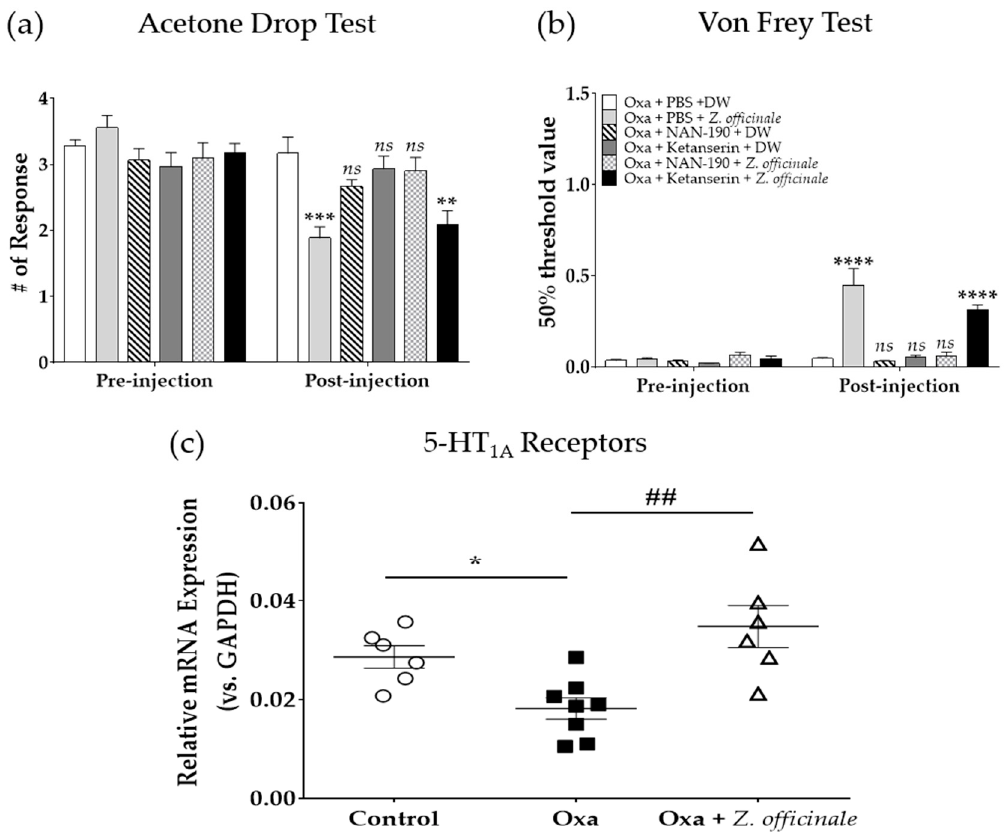
Figure 4. Effect of intrathecal injection of NAN-190 or ketanserin on Z. officinale -dependent inhibition of oxaliplatin-induced neuropathic pain in mice ( a,b ). Spinal mRNA expression level of 5-HT 1A receptors before and after oxaliplatin and Z. officinale treatment ( c ). Cold ( a ) and mechanical ( b ) allodynia were assessed by using the acetone drop and von Frey filament tests, respectively. On day 3 following oxaliplatin injection, NAN-190 or ketanserin was injected intrathecally in mice. PBS was used as a control for both NAN-190 and ketanserin. The relative mRNA expression of 5-HT 1A was measured before and after oxaliplatin injection and Z. officinale treatment ( c ). Control (Oxa + PBS + DW): n = 6, Oxa + PBS + Z. officinale :